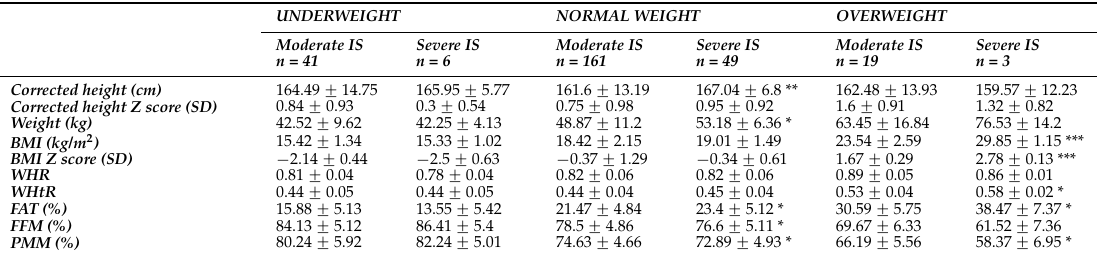
UNDERWEIGHT NORMAL WEIGHT OVERWEIGHT Moderate IS Severe IS Moderate IS Severe IS Moderate IS Severe IS n = 41 n = 6 n = 161 n = 49 n = 19 n = 3